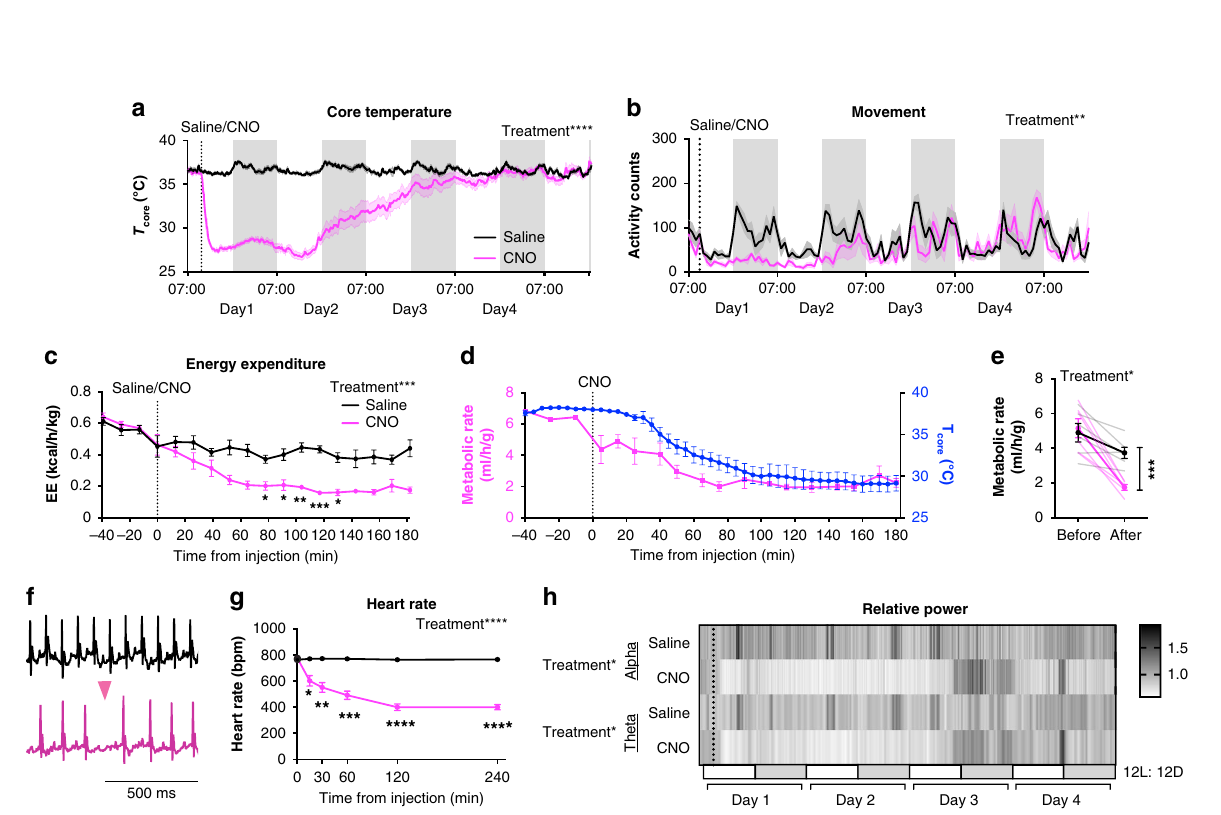
Fig. 2 Chemogenetic activation of ER α + MPA neurons induces a torpor-like state. AAV- fl ex-hM3Dq-mCherry was delivered to the MPA of female Esr1Cre mice. a , b Four-day consecutive recordings of core temperature and movement after saline (black, n = 8) or CNO (pink, n = 6) injection. Lines show group means, shaded area shows SEM. Results of pairwise comparisons for a , b are listed in Supplementary Files. c Energy expenditure (EE or Heat) calculated from indirect calorimetry data and normalized to lean body mass following saline or CNO injection ( n = 6). d Comparison of CNO-induced changes in metabolic rate (VO2 ml/h/g, pink) and T core (blue) in the same mice ( n = 4 Esr1Cre females). e Metabolic rate (VO2 ml/h/g) before ( − 40 min to 0 min) and after (120 min to 180 min) saline or CNO injection calculated from indirect calorimetry data and normalized to lean body mass ( n = 6 Esr1Cre females). f ECG traces in mice 4 h after saline or CNO injection. Traces representative of n = 8 mice. Pink arrowhead indicates a skipped heartbeat. g Heart rate ( n = 8) before (0 min) to 4 h after saline or CNO injection. h Heatmap of relative alpha and theta power from four-day consecutive EEG recording after saline or CNO injection (dash line, n = 4). White and gray bars below represent light and dark periods, respectively. Group means ± SEM shown. * p < 0.05; ** p < 0.01;*** p < 0.001; **** p < 0.0001 for Sidak ’ s multiple comparison tests comparing saline and CNO following a signi fi cant effect of treatment a ( p < 0.0001), b ( p = 0.0020), c ( p = 0.0006), e ( p < 0.05), g ( p < 0.0001), and h (Alpha p = 0.04 and theta p = 0.02) in a two-way RM